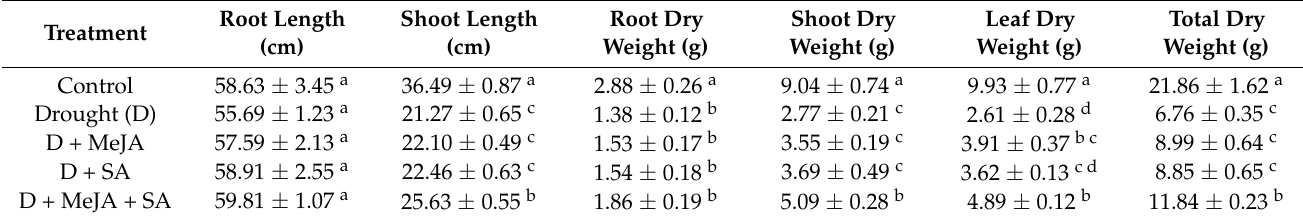
Table 1. Effect of methyl jasmonate (MeJA), salicylic acid (SA), and their combined application on the growth parameters of French beans under drought stress.